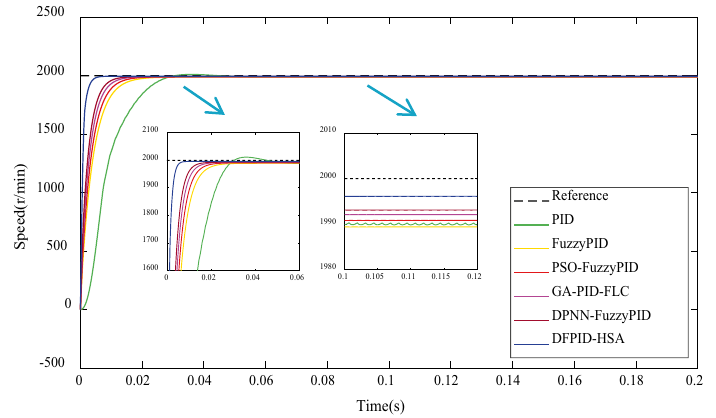
Figure 11. The comparison of speed response under the no-load condition.